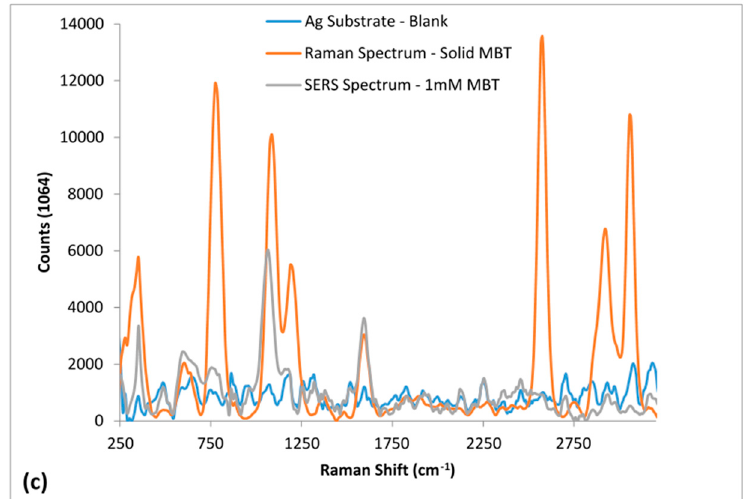
Figure 6. Raman and SERS spectra of MBT recorded using 514 nm and 1064 nm Raman spectrometers: ( a ) 514 nm and 1064 nm Raman spectra of solid MBT; and ( b , c ) 514 nm and 1064 nm SERS spectra respectively, for 1 mM MBT on 30 s NH 4 OH + 10 s HNO 3 Ag substrate compared to Raman spectrum of solid MBT and the base Ag substrate (blank). Table 3 . Raman and SERS peaks (cm − 1 ) for MBT on spectra recorded using 514 nm and 1064 nm Raman spectrometers and the peak assignments. 514 nm Raman Peaks (cm − 1 ) Peak Assignment Raman